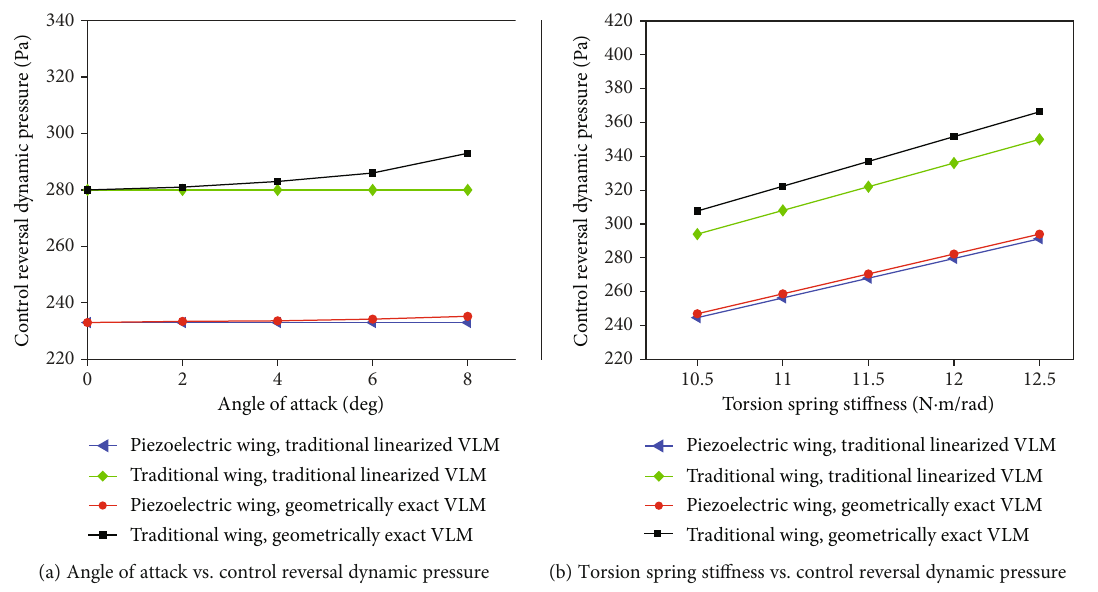
Figure 9: Factors related to the control reversal dynamic